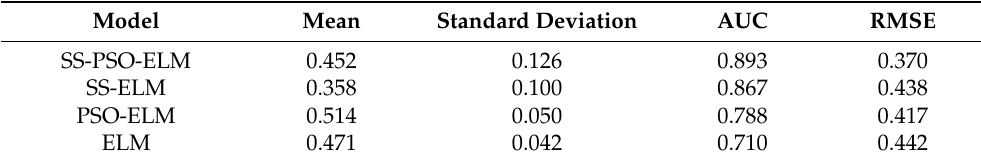
Table 2. Model evaluation